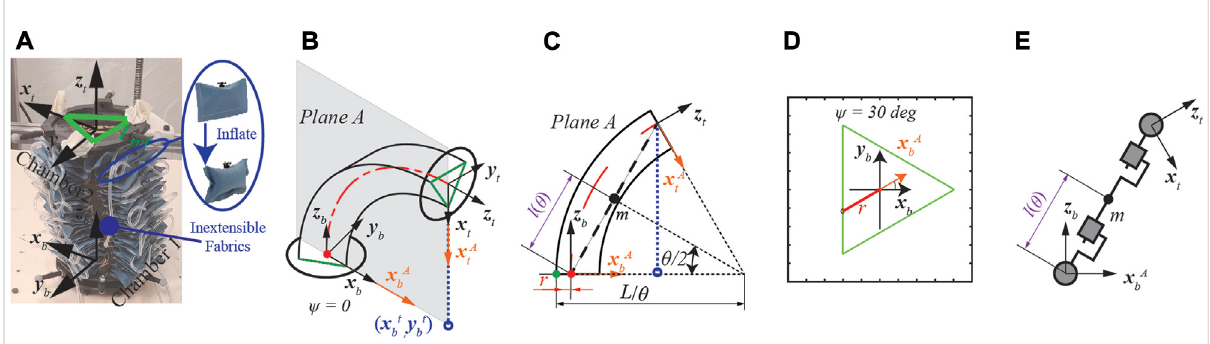
FIGURE 1 Modi fi ed augmented rigid arm model for the fabric-based actuator. (A) Isometric view of the actuator. (B) Curvature plane with rotation angle ψ =0deg. (C) Themodi fi edmodelwiththeadditionofparameter ronthecurvatureplane.Thegreen andredlinesindicatetheinextensiblelayerand the axial line, respectively. (D) Top view of bottom plate when ψ = 30deg. (E) Augmented rigid arm